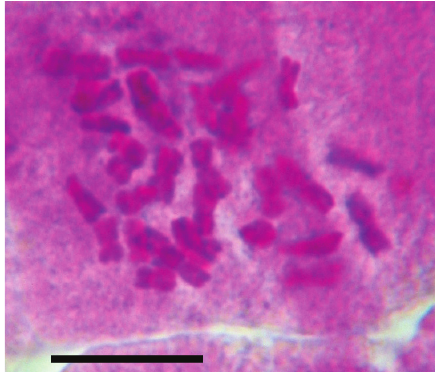
Figure 2. Hieracium portanum Belli, 2 n = 36. Scale bar: 10 µm.